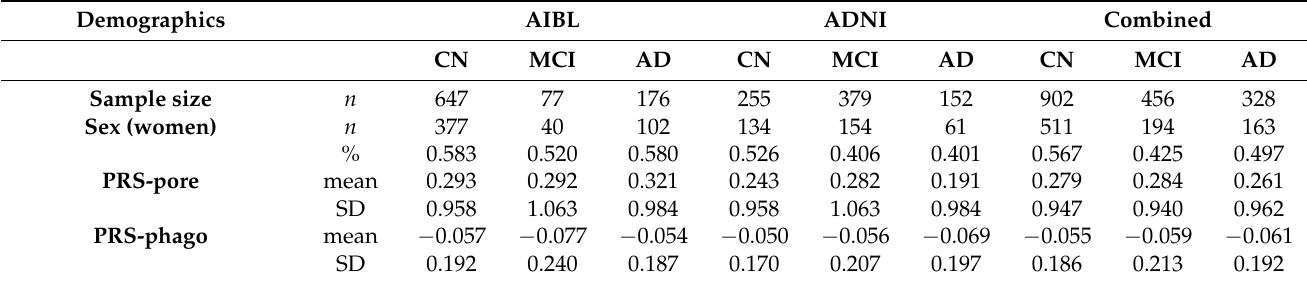
Table 2. Characteristics of sample cohorts with two PRS